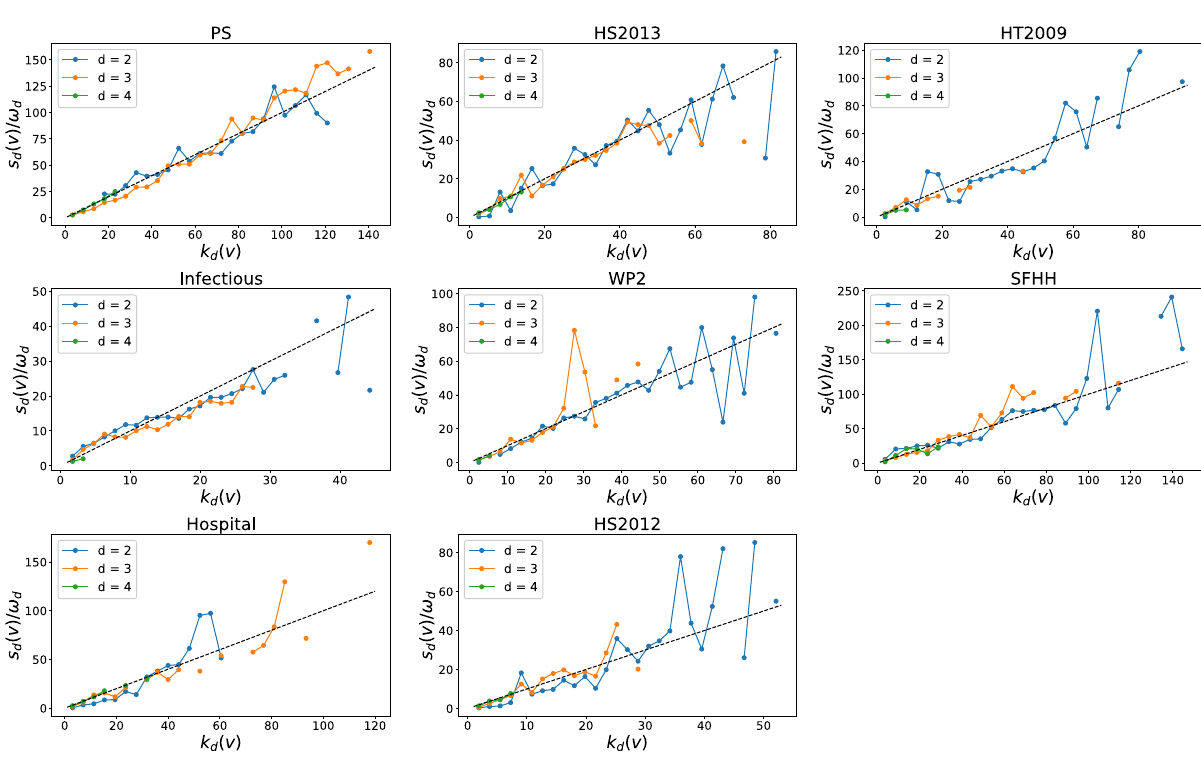
Figure 9. The d -strength s d ( v ) versus the the d -degree k d ( v ) of a node v when d is equal to 2 (blue line), 3 (yellow line) and 4 (green line) respectively in each physical contact network. The vertical axis is normalized by the average number ω d of activations of a hyperlink of order d . The dashed line represent the reference